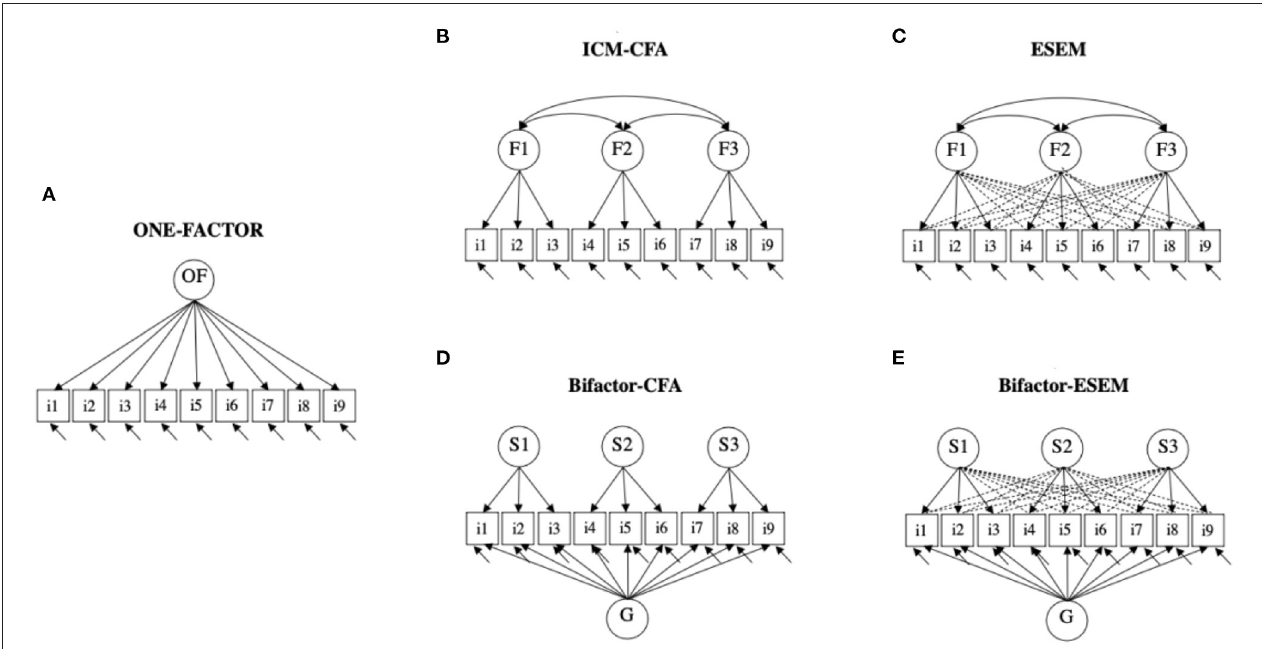
FIGURE 1 | Simplified graphical representations of five alternative models of early numeracy: (A) the one-factor model (OF), (B) the independent cluster model (ICM-CFA), (C) the exploratory structural equation model (ESEM), (D) the bifactor-CFA model (Bifactor-CFA), and (E) the bifactor exploratory structural equation model